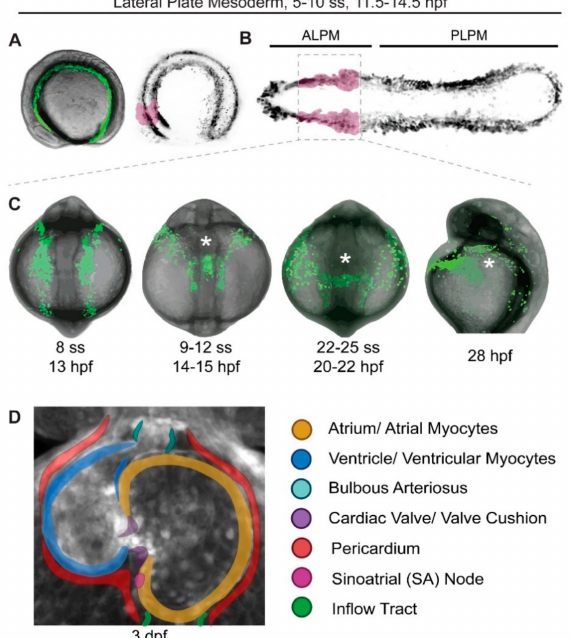
Figure 1. Earliest stages of cardiac development in zebrafish. Stages of zebrafish heart formation from lateral plate mesoderm (LPM). ( A , B ) LPM during early somitogenesis on three-dimensional ( A ) and virtually flat-mounted ( B ) zebrafish embryo, anterior to the left. The prospective bilateral heart field is marked in magenta within the anterior LPM (ALPM). ( C ) Stages of heart field convergence at the midline, formation of the cardiac disc and cone, migration to the left, and early heart tube stages; maximal projection of z-stack of drl:EGFP transgenics [24], anterior (head) to the top, with the embryo curved over the yolk at this stage (tail end behind the yolk in the first three panels, out of view in the right-most panel). Note how the bilateral ALPM migrates to the midline and forms the leftward-moving heart tube (asterisks). ( D ) 72 hpf (3 dpf) zebrafish heart with all major parts color-coded, anterior/rostral to the top; greyscale max projection of z-stack of ubi:Zebrabow transgenics overlaid with annotation of individual structures [25]. See text for details, images not to